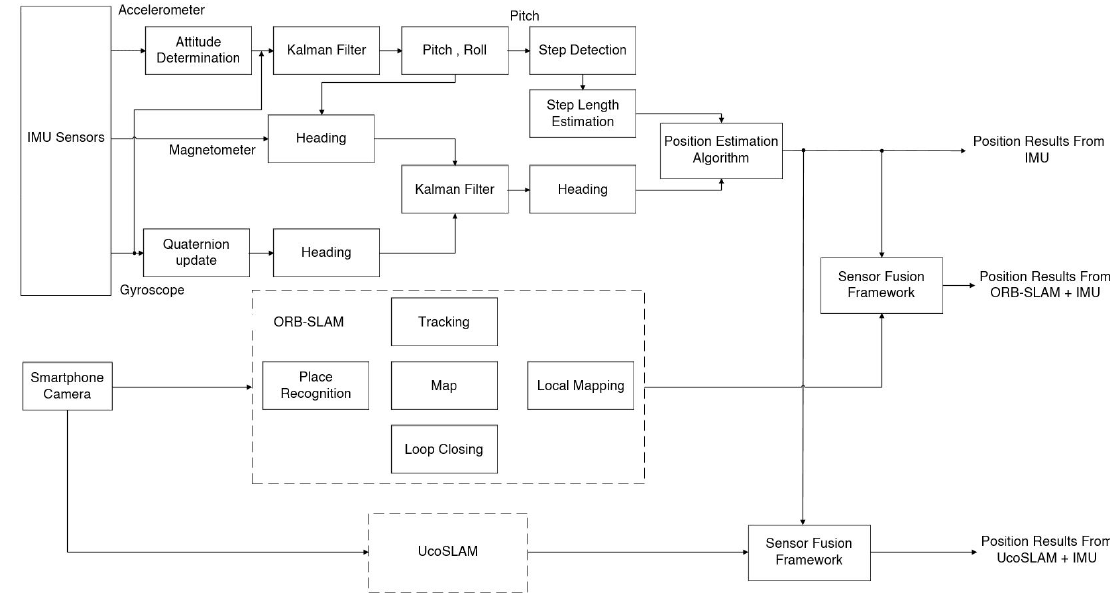
Figure 1. Proposed hybrid indoor localization model using IMU sensor and smartphone